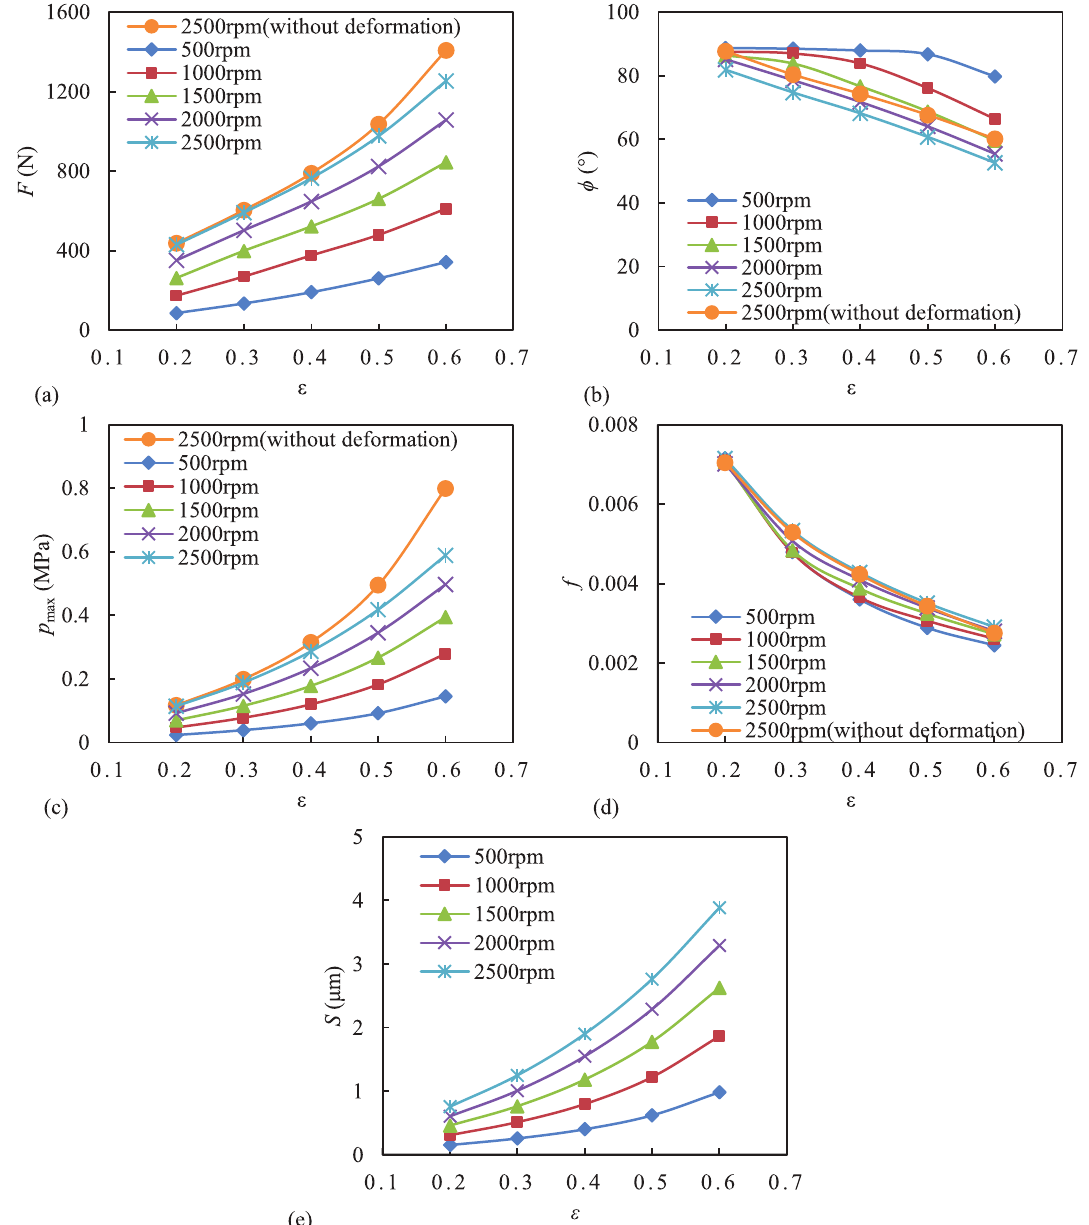
Fig. 11. Effect of rotational speed on the lubrication performance of double-layer bearing (a) Load carrying capacity, (b) Attitude angle, (c) Maximum water fi lm pressure, (d) Friction coef fi cient, (e) Maximum bearing bush deformation, for t1 = t2= 5 mm, E1 = 1000 MPa, E2 = 400 MPa, n1 = 0.4, n2 =